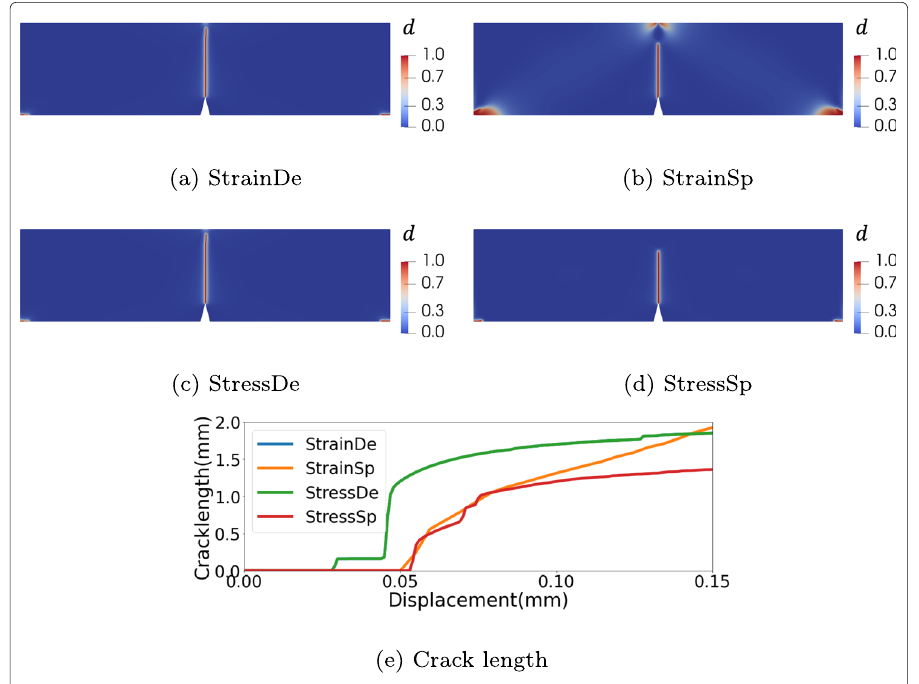
Fig. 11 Fracture results from the three-point bending simulations with the load and boundary conditions applied at seven nodes: ( a ) - ( d ) final crack paths for the strain deviatoric, strain spectral, stress deviatoric, and stress spectral methods, respectively. ( e ) crack length evolution for the four